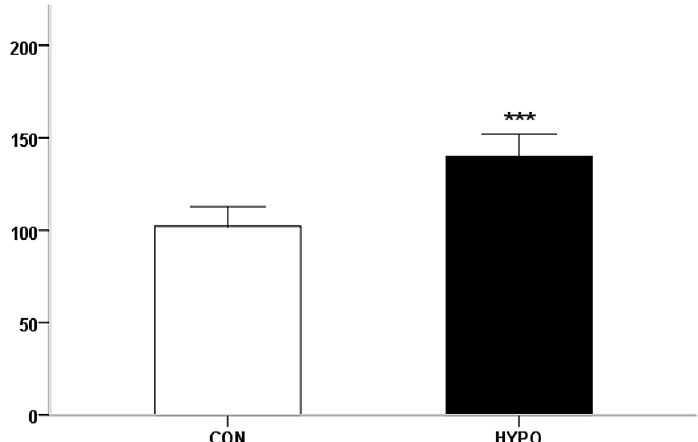
there were significant differences in immobility time between baseline and week 5.